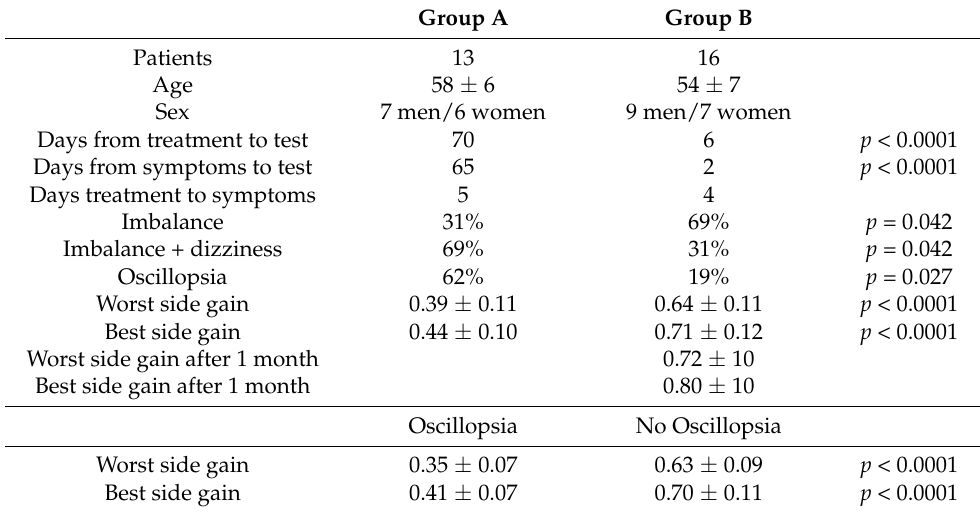
Table 1. Main data of the sample.